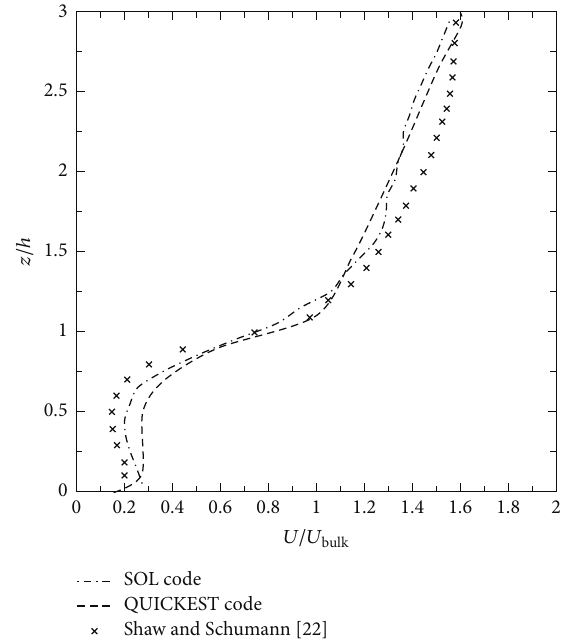
Figure 2: Spatial mean longitudinal velocity profiles for a leaf area index equal to